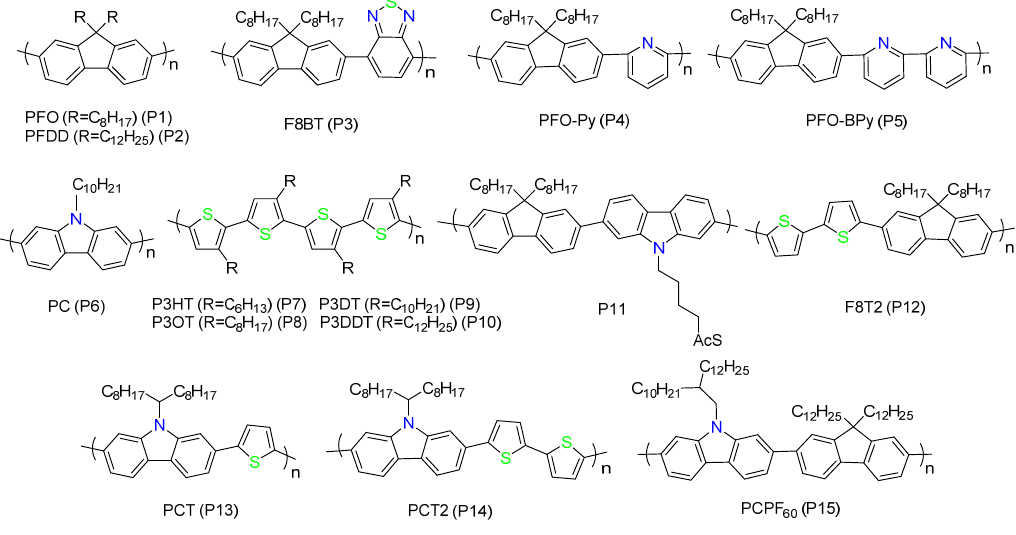
Figure 3. Structures of typical conjugated polymers used for sorting s ‐ SWNTs.